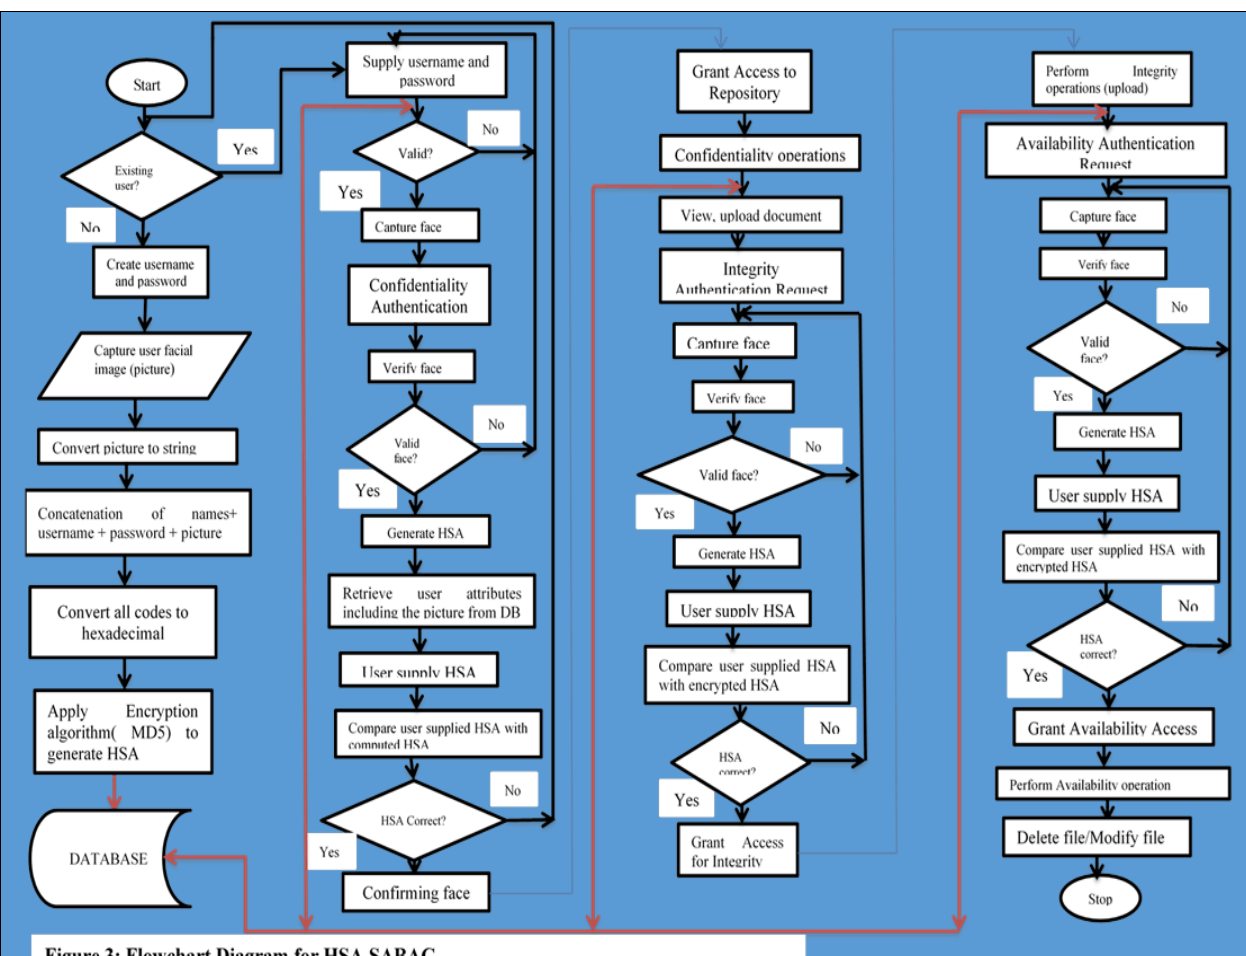
Figure 3: SABAC Model Flowchart Source: Authors,